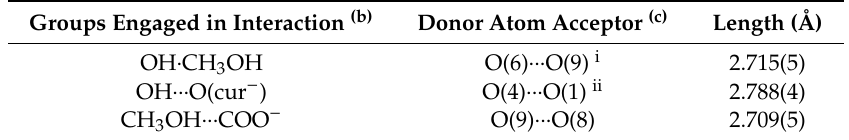
Table 2. Hydrogen-bonding interactions in [Zn(PhCOO)(cur)(bpy)]( 2 ) · CH 3 OH (a) . Groups Engaged in Interaction (b)